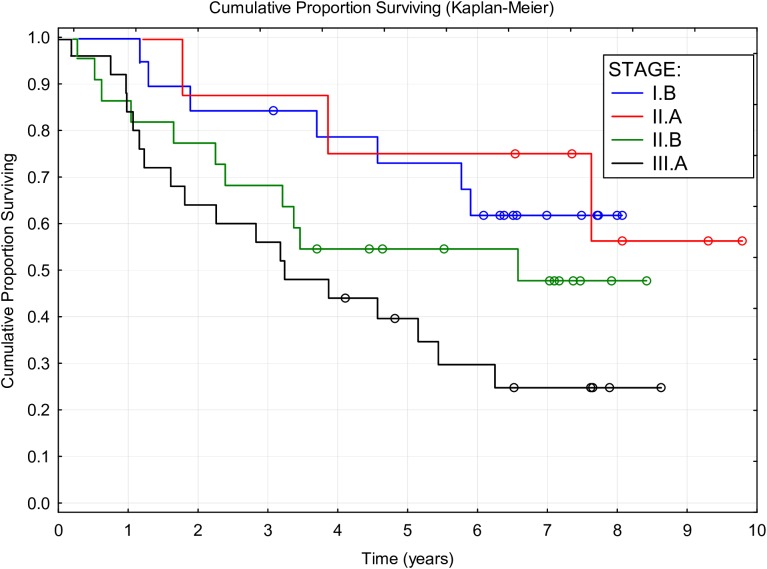
Overall survival by disease stage.